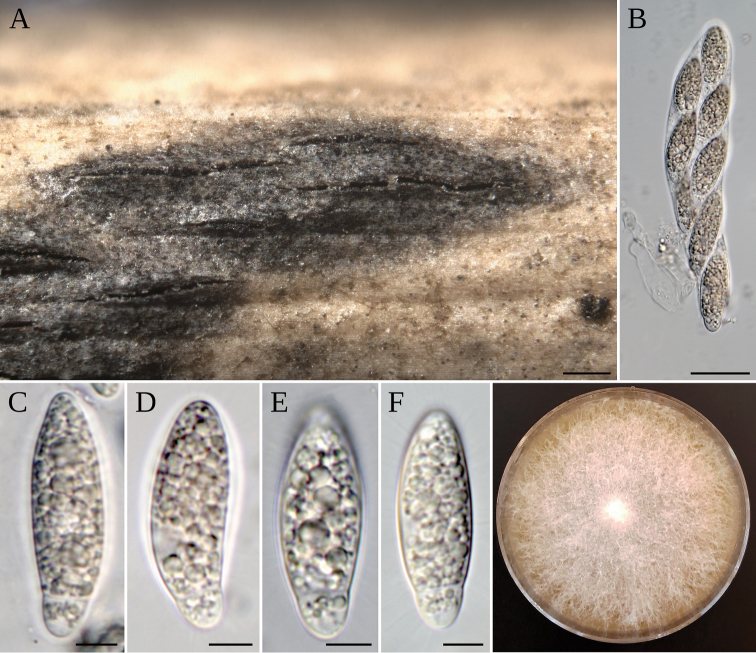
A.balearicumA stromata on host; B asci C–F ascospores G colony on MEA. Scale bars: 200 µm (A); 20 µm (B); 5 µm (C–F).